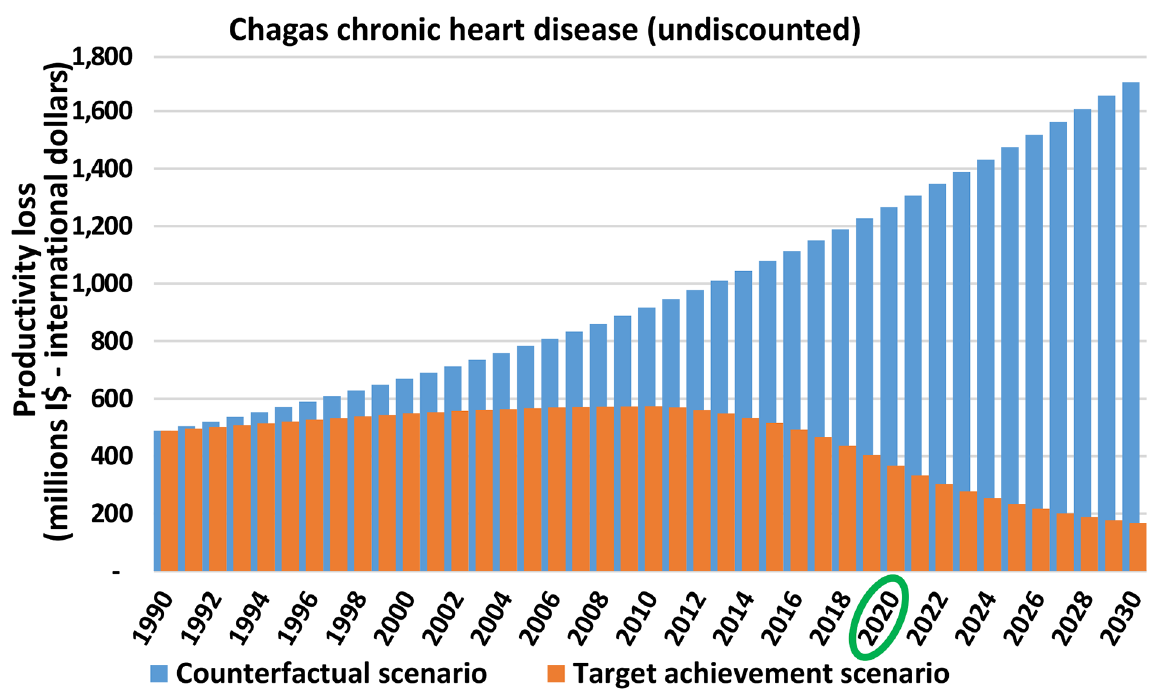
Fig 3. Productivity loss due to Chagas chronic heart disease according to the counterfactual and target achievement scenarios (millions I$ —International dollars). Total global loss per year in the counterfactual scenario (blue) and target achievement scenario (orange). The economic benefit is the difference between both